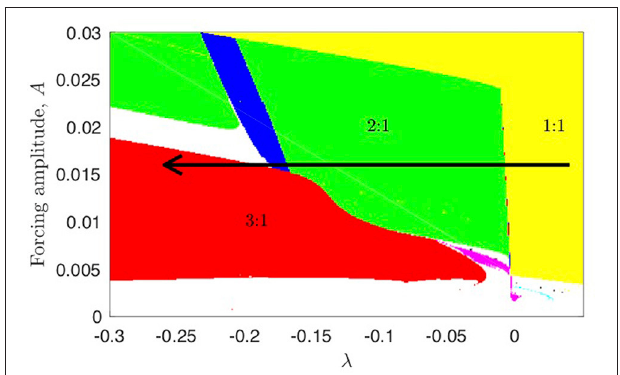
FIGURE 15 | As a function of the forcing amplitude A and the parameter λ the frequency of the oscillator (7) synchronizes in rational ratio to the forcing frequency ω F . The colored patches of synchronization correspond to the frequency locking shown in Figure 7 . The arrow indicates the change corresponding to the change of α through the MPT shown in Figure 12